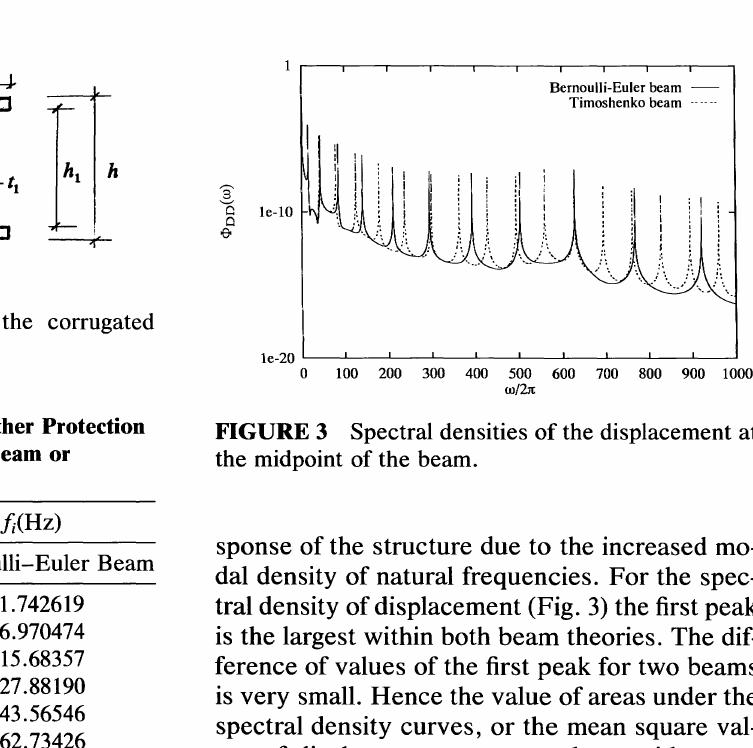
dal density of natural frequencies. For the spec